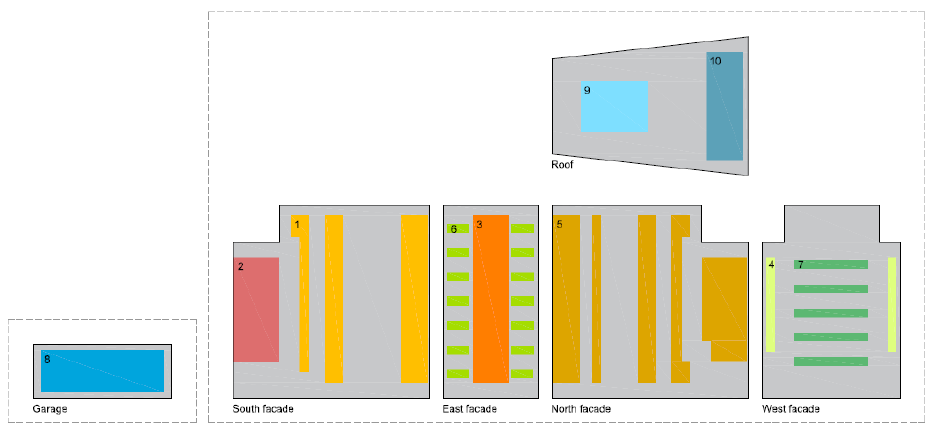
Figure 7. Schematic façade breakdown according with building component, orientation and PV